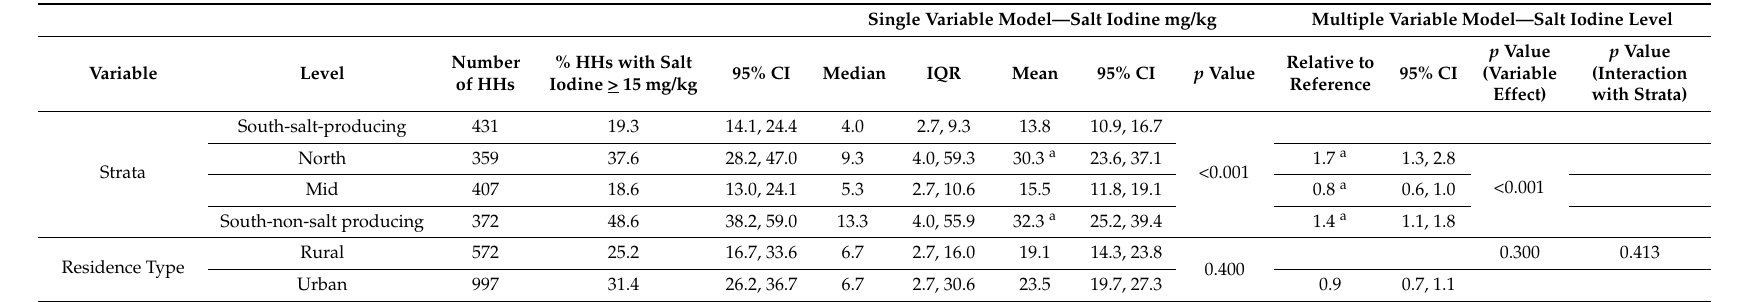
Table 4. Regression analyses of factors associated with household salt iodine